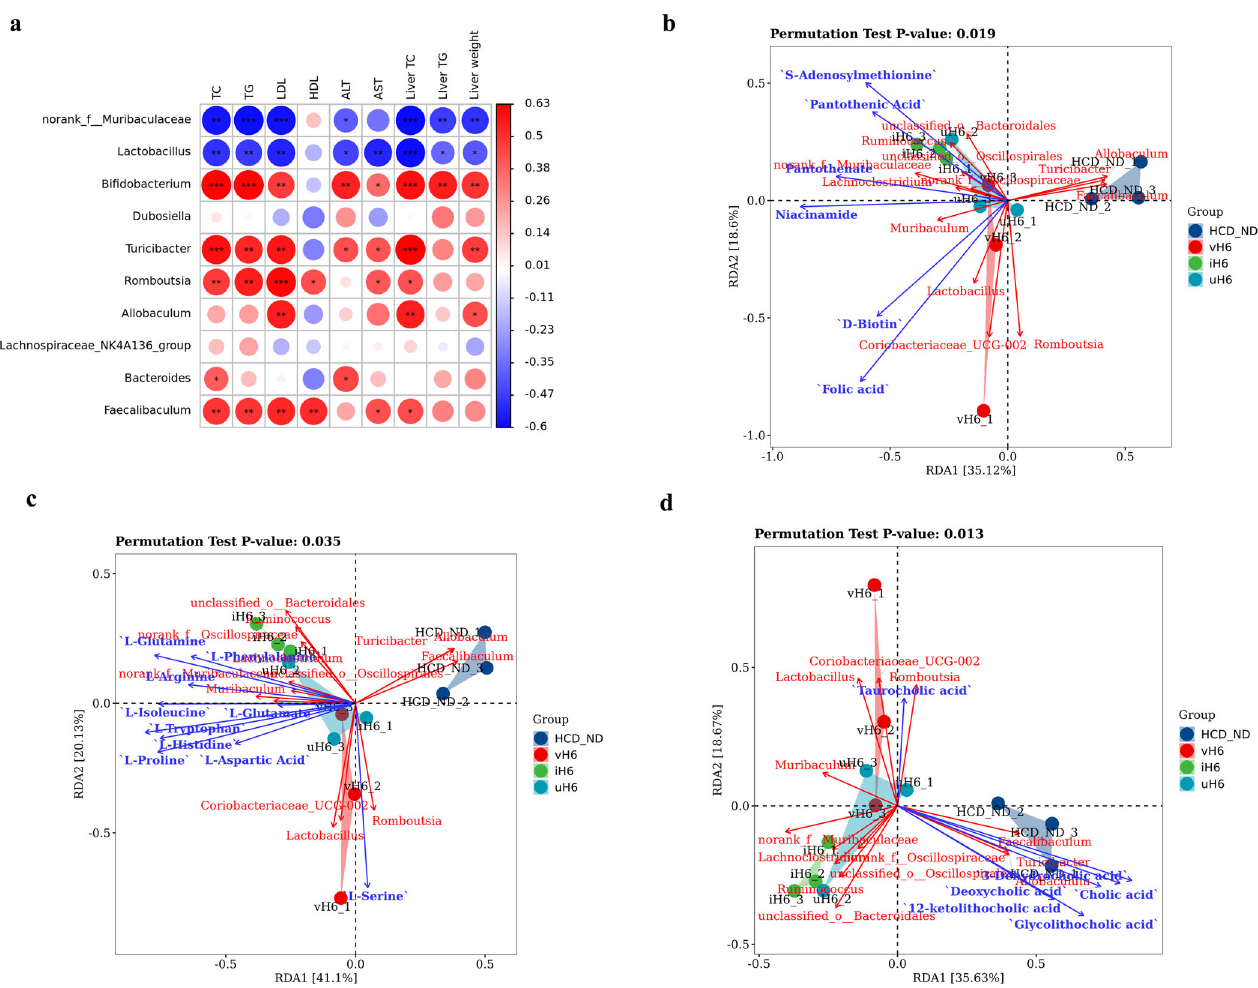
Fig. 6 The correlation analysis of physicochemical indexes and metabolites of mice given v/i/uH6. a Correlation analysis between top 10 richest bacteria and physicochemical indices of hypercholesterolemia by Spearman method. b – d Redundancy analysis (RDA) of the correlation between v/i/uH6 microbial community and fecal metabolites (vitamins-cofactors, amino acids, bile acids). Data are presented as the mean ± SEM ( n = 3). * P < 0.05, ** P < 0.01, *** P < 0.001. HCD_ND refers to the group of hypercholesterolemia model mice; v/i/uH6 refers to viable (vH6), heat-inactivated (iH6), and ultrasonically lysed (uH6) bacteria